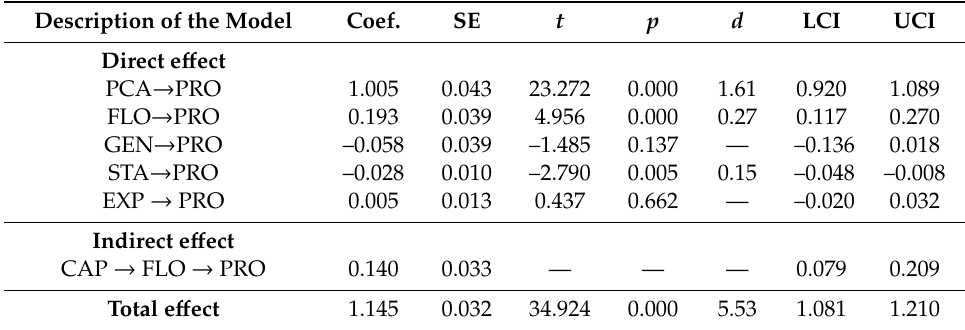
Table 4. Results of the mediation analysis of flourishing in the relationship between PsyCap and professional accomplishment. Description of the Model